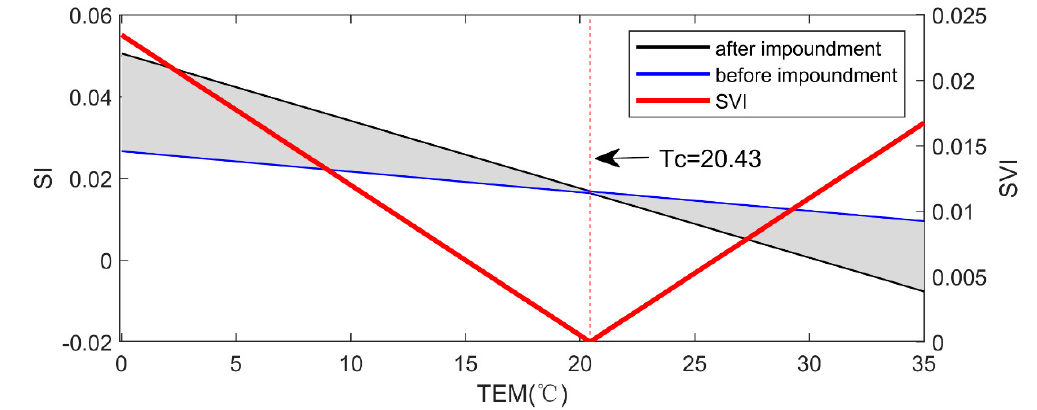
Figure 11. The sensitivity index (SI) and sensitivity variation index (SVI) for the NDVI–temperature response in 0–10 km zone (PRE = 200 mm).